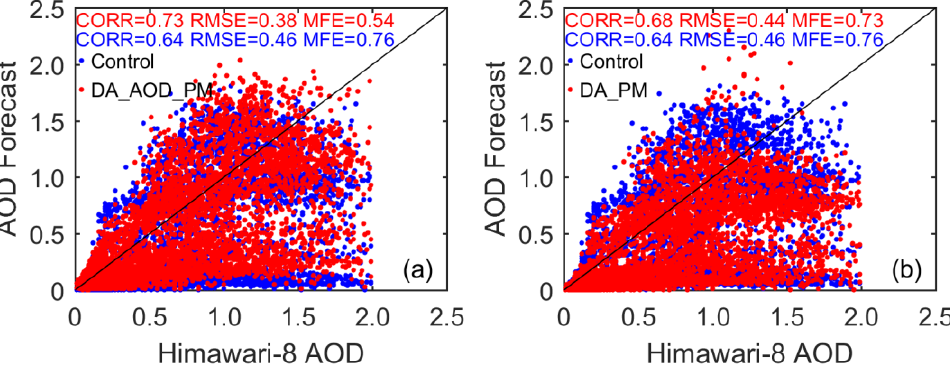
Figure 8. Comparison between the AOD measurements and the 24 h AOD forecasts (at 0500 UTC on 13 January 2019) of ( a ) Control and DA_AOD_PM and ( b ) control and DA_PM.